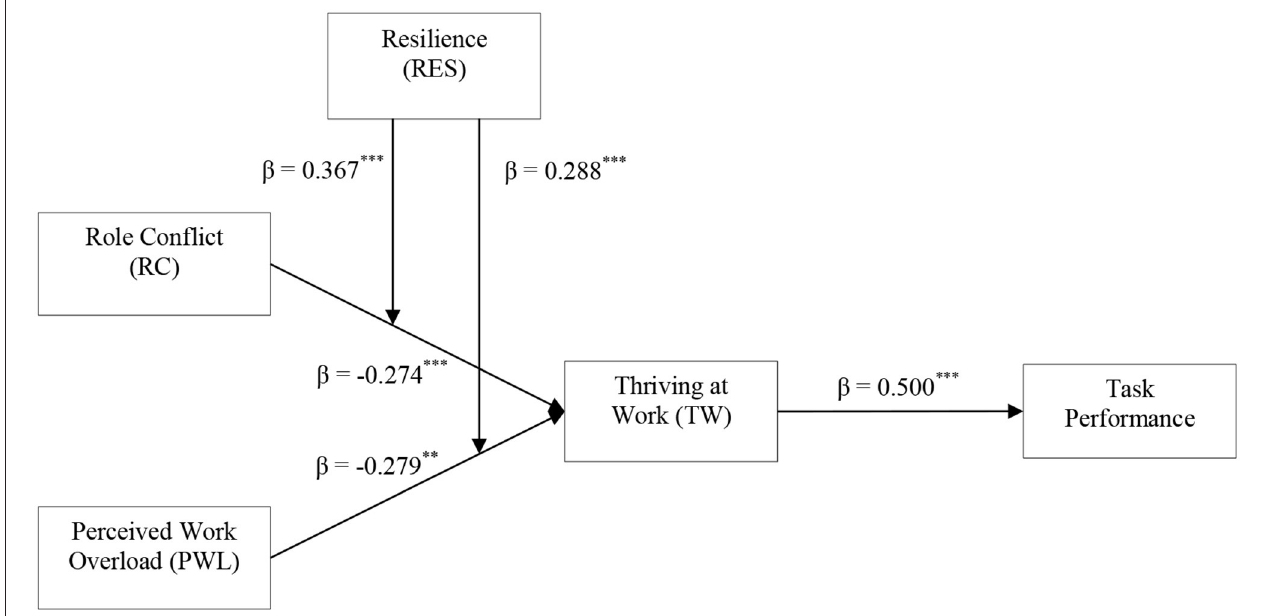
TABLE 2 | Indirect paths. Path Coefficients Boot SE CI. 95% Relationship